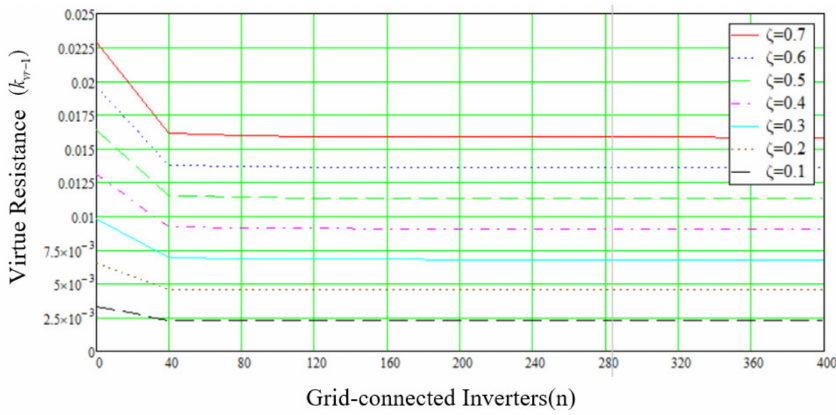
Figure 9. Curve of virtue resistance relative to the number of grid-connected inverters